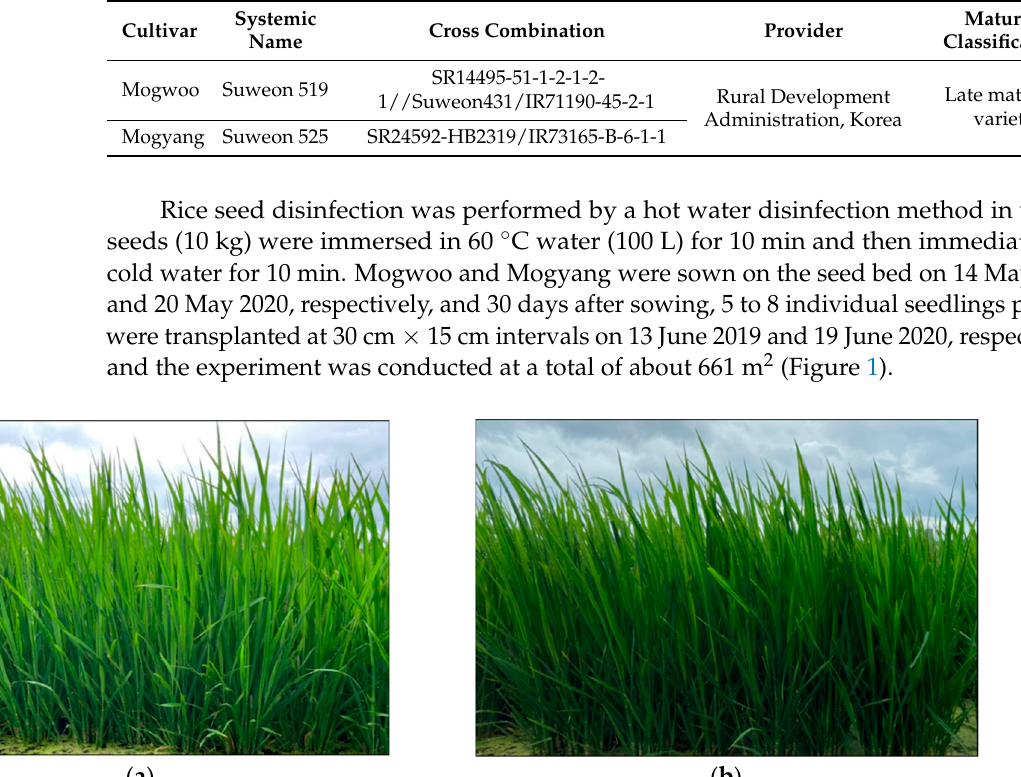
Table 1. The cross combination and main characteristics of ‘Mogwoo’ and ‘Mogyang’ in forage rice.